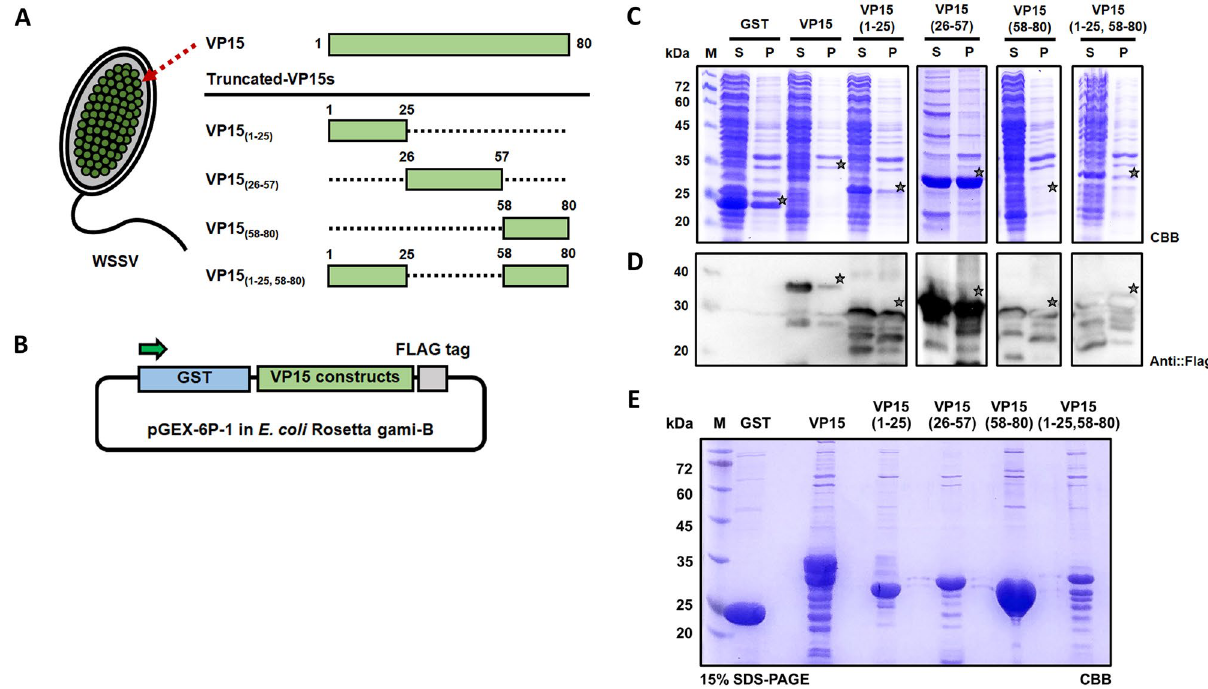
Figure 1. Expression of the truncated WSSV-VP15 series using the E. coli expression system. ( A ) Schematic diagram representing a major nucleocapsid protein of WSSV-VP15. Four truncated VP15 constructs were generated as illustrated and were named VP15 (1–25) , VP15 (26–57) , VP15 (58–80) , and VP15 (1–25,58–80) . The numbers represent the amino acid position. ( B ) Construction of plasmids harboring the VP15 truncated series for expression using the E. coli system and expression verification via SDS-PAGE. GST: glutathione-S-transferase as a fusion tag and for affinity purification; Flag: DYKDDDDK epitope tag for Western blot analysis. ( C ) Coomassie brilliant blue-stained SDS-PAGE gel of E. coli expressing VP15 truncated constructs and ( D ) Western blot analysis of the expressed recombinant proteins. Anti-Flag antibody was applied for the detection of the target proteins. M: marker; S: supernatant; and P: precipitate. ( E ) SDS-PAGE analysis of purified VP15 and truncated VP15 series. Each recombinant protein was purified via GST affinity chromatography. The theoretical sizes of VP15, VP15 (1–25) , VP15 (26–57) , VP15 (58–80) , and VP15 (1–25,58–80) were 37.0, 30.8, 31.6, 30.5, and 33.4 kDa, respectively. A main purified product of VP15 (1–25) , VP15 (26–57) , and VP15 (58–80) can be observed corresponding to the estimated size of the protein with minor bands below the main product. However, a purified product of VP15 and VP15 (1–25,58–80) has several bands below the main product. GST was loaded as a control. M indicates a protein